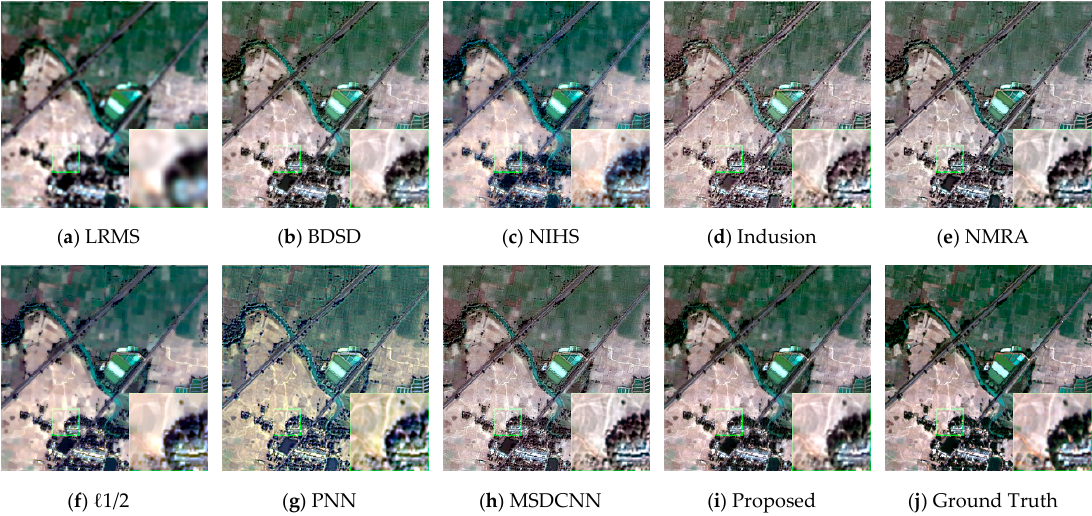
Figure 10. Results of the reduced scale experiment on an area extracted from a QuickBird image. ( a ) LRMS; ( b ) BDSD; ( c ) NIHS; ( d ) Indusion; ( e ) NMRA; ( f ) ℓ 1/2; ( g ) PNN; ( h ) MSDCNN; ( i ) Proposed; ( j ) Ground Truth.